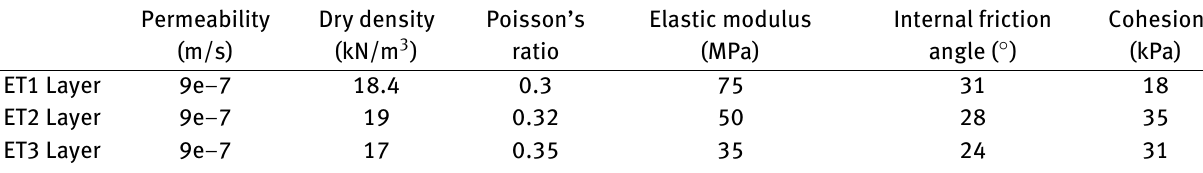
Table 4: Soil layer specifications